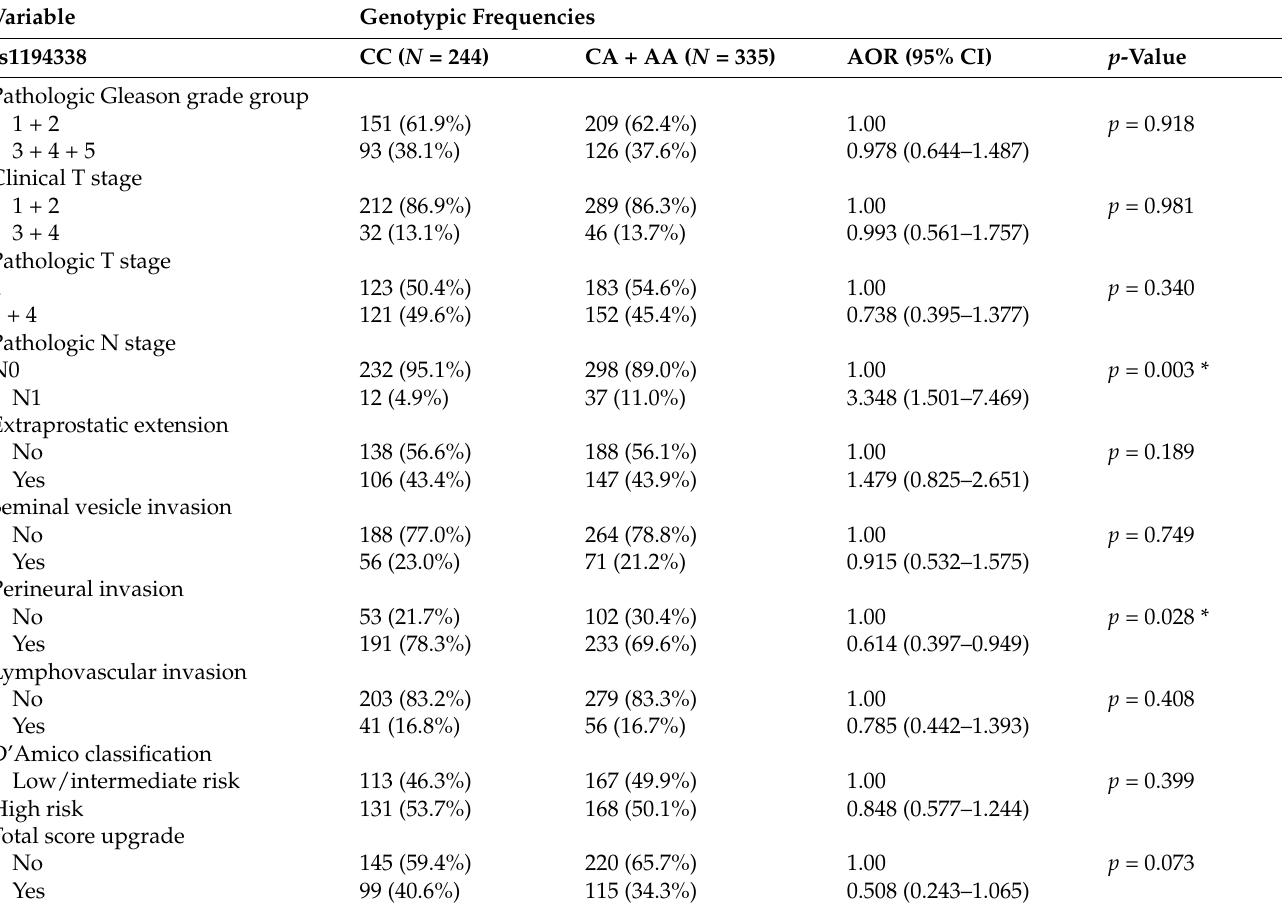
Table 4. Odds ratio (OR) and 95% confidence interval (CI) of clinical status and MALAT1 rs1194338 genotypic frequencies in 579 patients with prostate